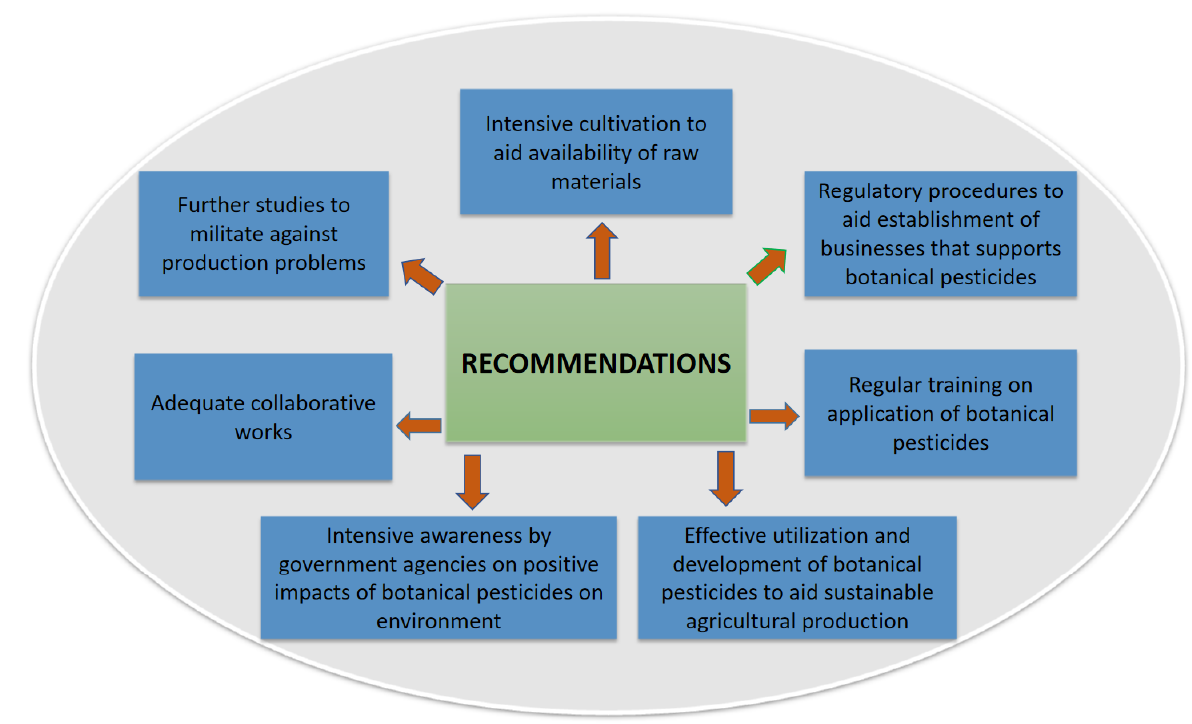
Figure 2. Recommendations to improve the use of botanical pesticides.